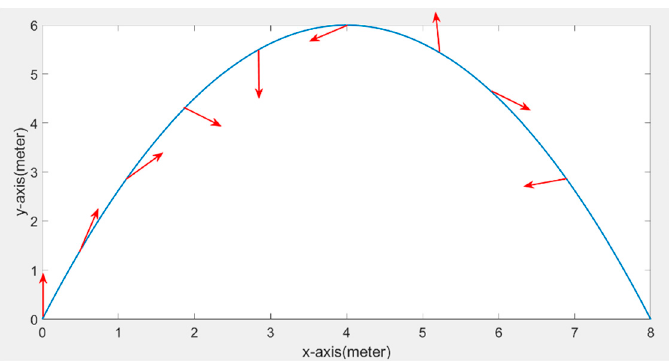
Figure 8. Structure of the OMR with four PCWs. Figure 9. Cosine-functional curvilinear path.